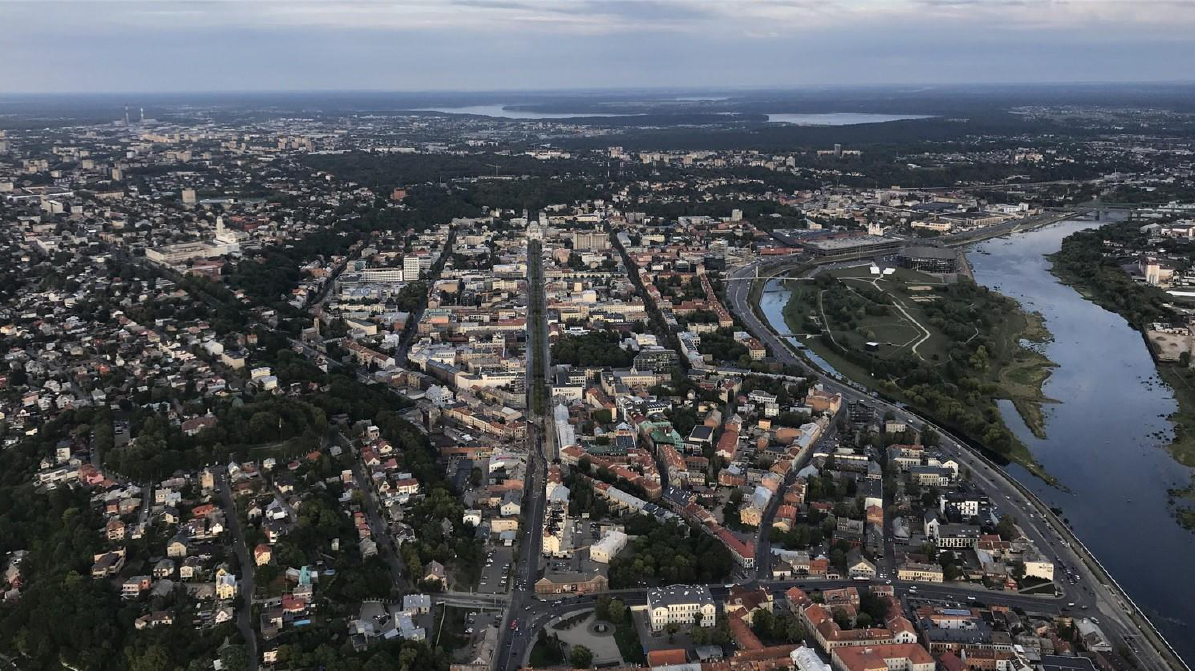
Figure 1. Kaunas from a bird’s view: Naujamiestis by the river and Žaliakalnis on the hills. Aerial photo: Živilė Šimkutė, 2019.